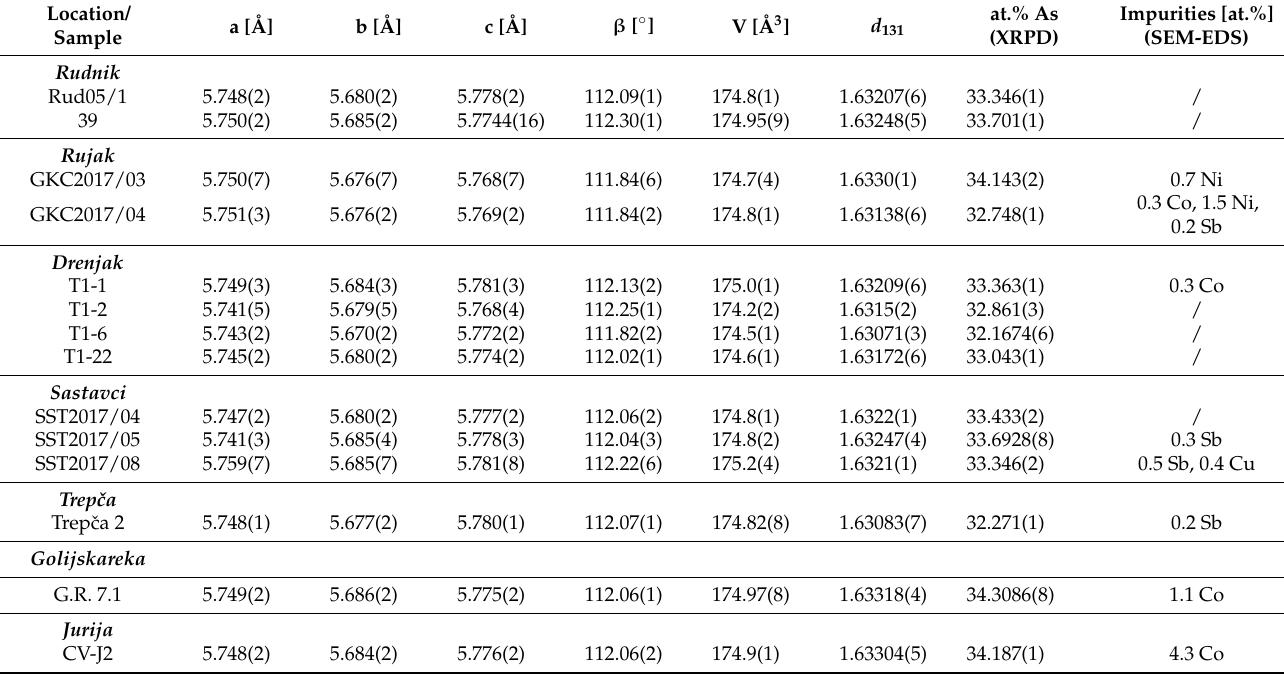
Table 1. X-Ray Powder Diffraction (XRPD) results for analysed arsenopyrite samples; α , γ = 90 ◦ . Location names are bold italic, and sample names in regular text. The at.% As was calculated from XRPD data according to [14]. Impurities were determined as an average of 15 SEM-EDS